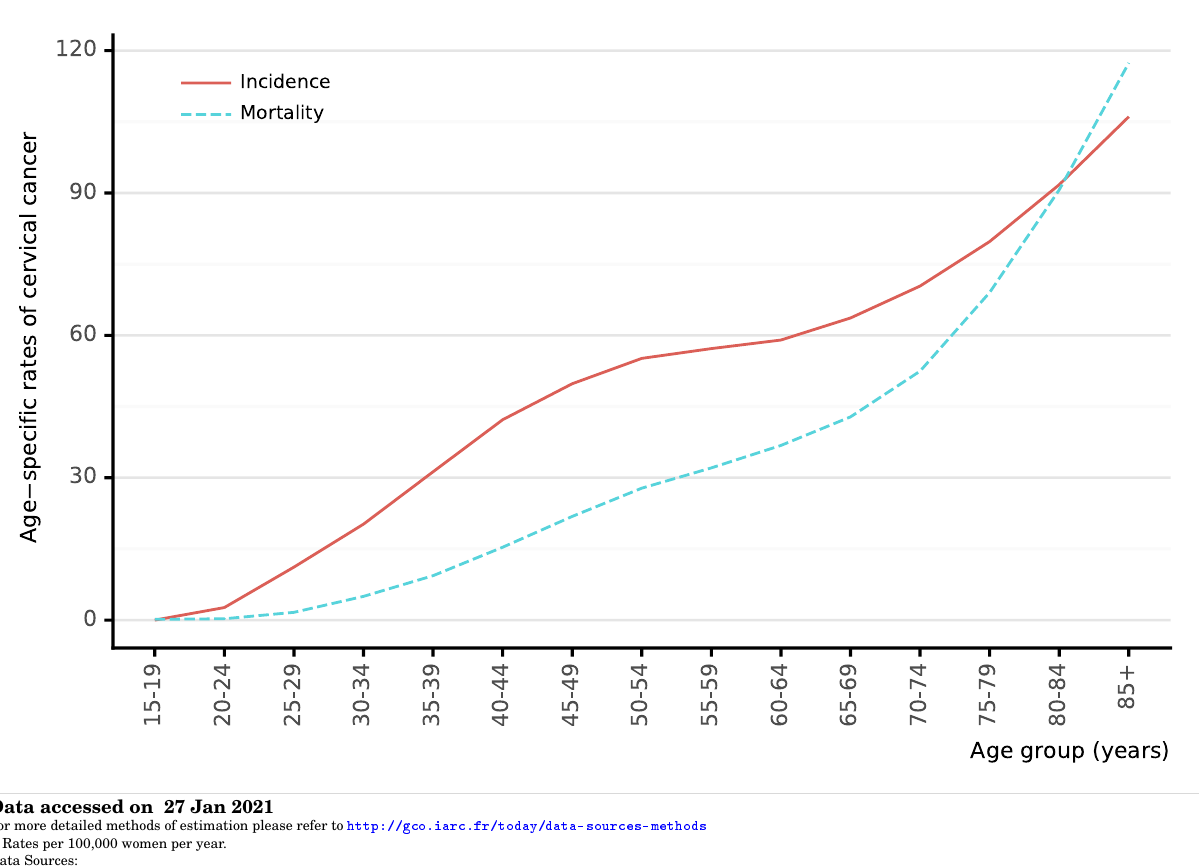
Table 6: Premature deaths and disability from cervical cancer in Peru, Americas and the rest of the world (estimates for 2019)